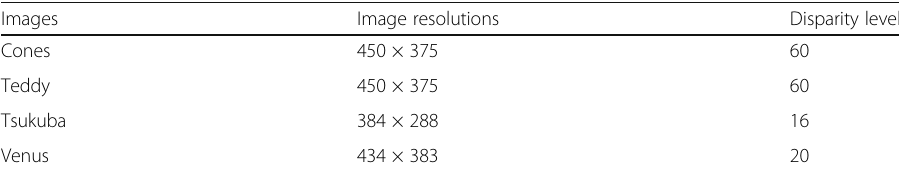
Table 1 Image information of Middlebury